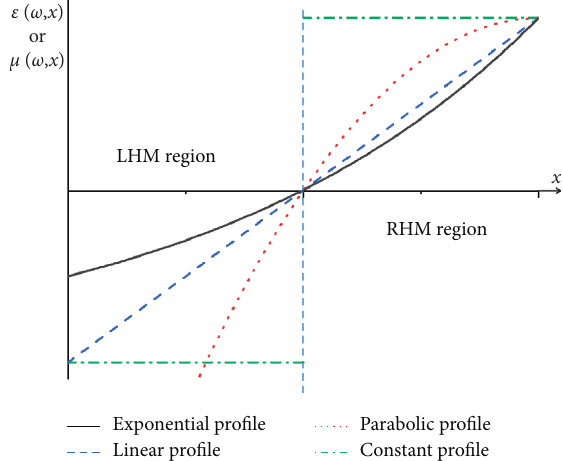
Figure 2: Gradual spatially varying effective permittivity ϵ ( ω , x ) and permeability μ ( ω , x ) of CRLHM with exponential, linear, parabolic, and constant profile